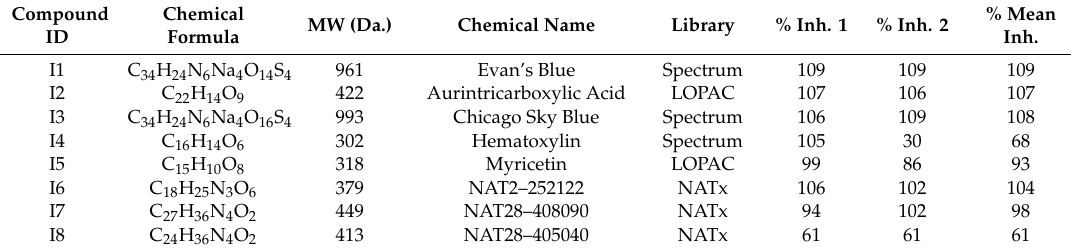
Table 3. E234G HYPE inhibitor hit information.